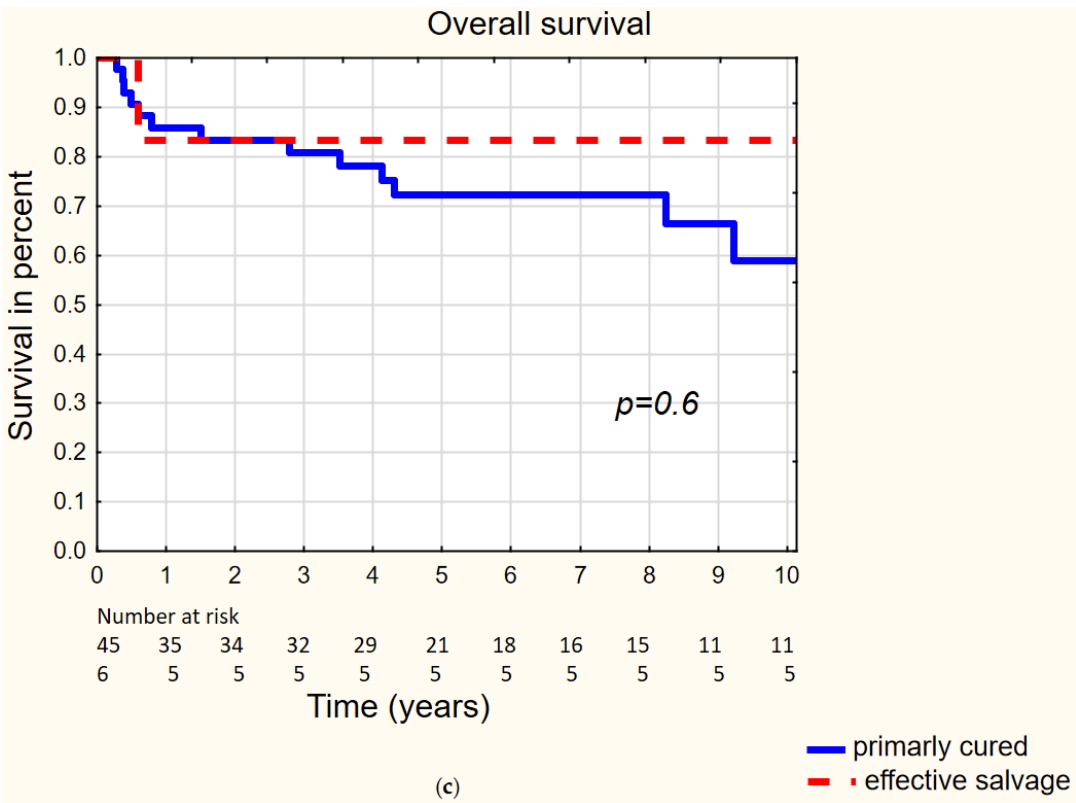
Figure 2. Overall survival considering salvage after primary treatment failure. ( a ) Patients with treatment failure: salvage vs. no salvage. ( b ) Patients after salvage: effective salvage vs. ineffective salvage. ( c ) Patients cured primarily vs. cured after salvage.